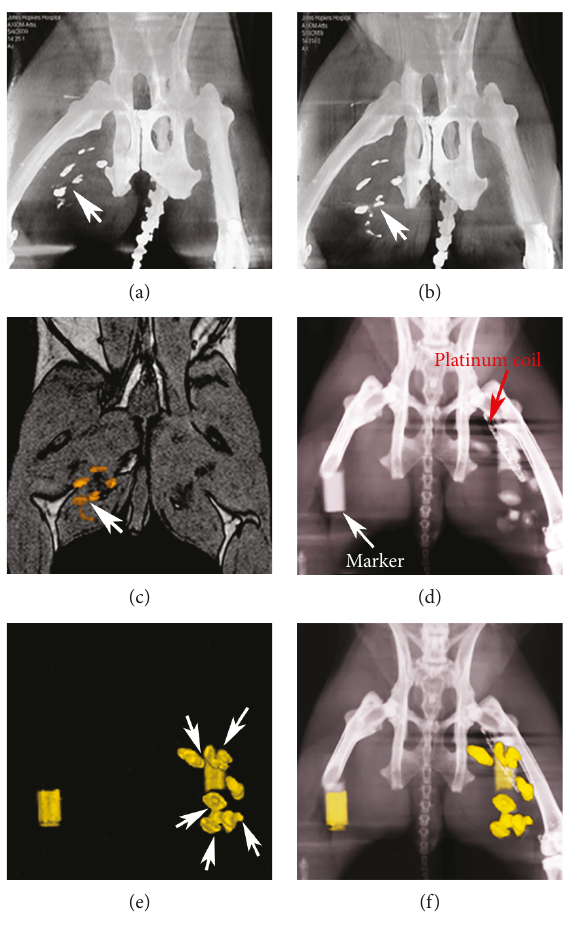
Figure 4: In vivo visualization of PFOBCaps in normal and PAD rabbits. (a) Multiplanar reformat of a C-arm CT in a normal rabbit demonstrates the detection of six PFOBCap injections in the right thigh (arrow) immediately after injection. (b) C-arm CT image of the same rabbit as (a) shows the persistence of PFOBCap injections two weeks after delivery. (c) In vivo 19 F MRI of PFOB Caps overlaid on anatomical 1 H MRI shows the detection of PFOBCap injection sites two weeks after delivery. (d) C-arm CT image of a PAD rabbit shows additional radiopacities such as coil (dash line) beyond PFOBCaps. (e) 19 F MRI of PFOBCaps in the same rabbit as (d) shows all six injections of PFOBCaps in the left thigh (arrows). (f) Fusion of (d) and (e) reveals one-to-one correspondence of PFOBCap injection